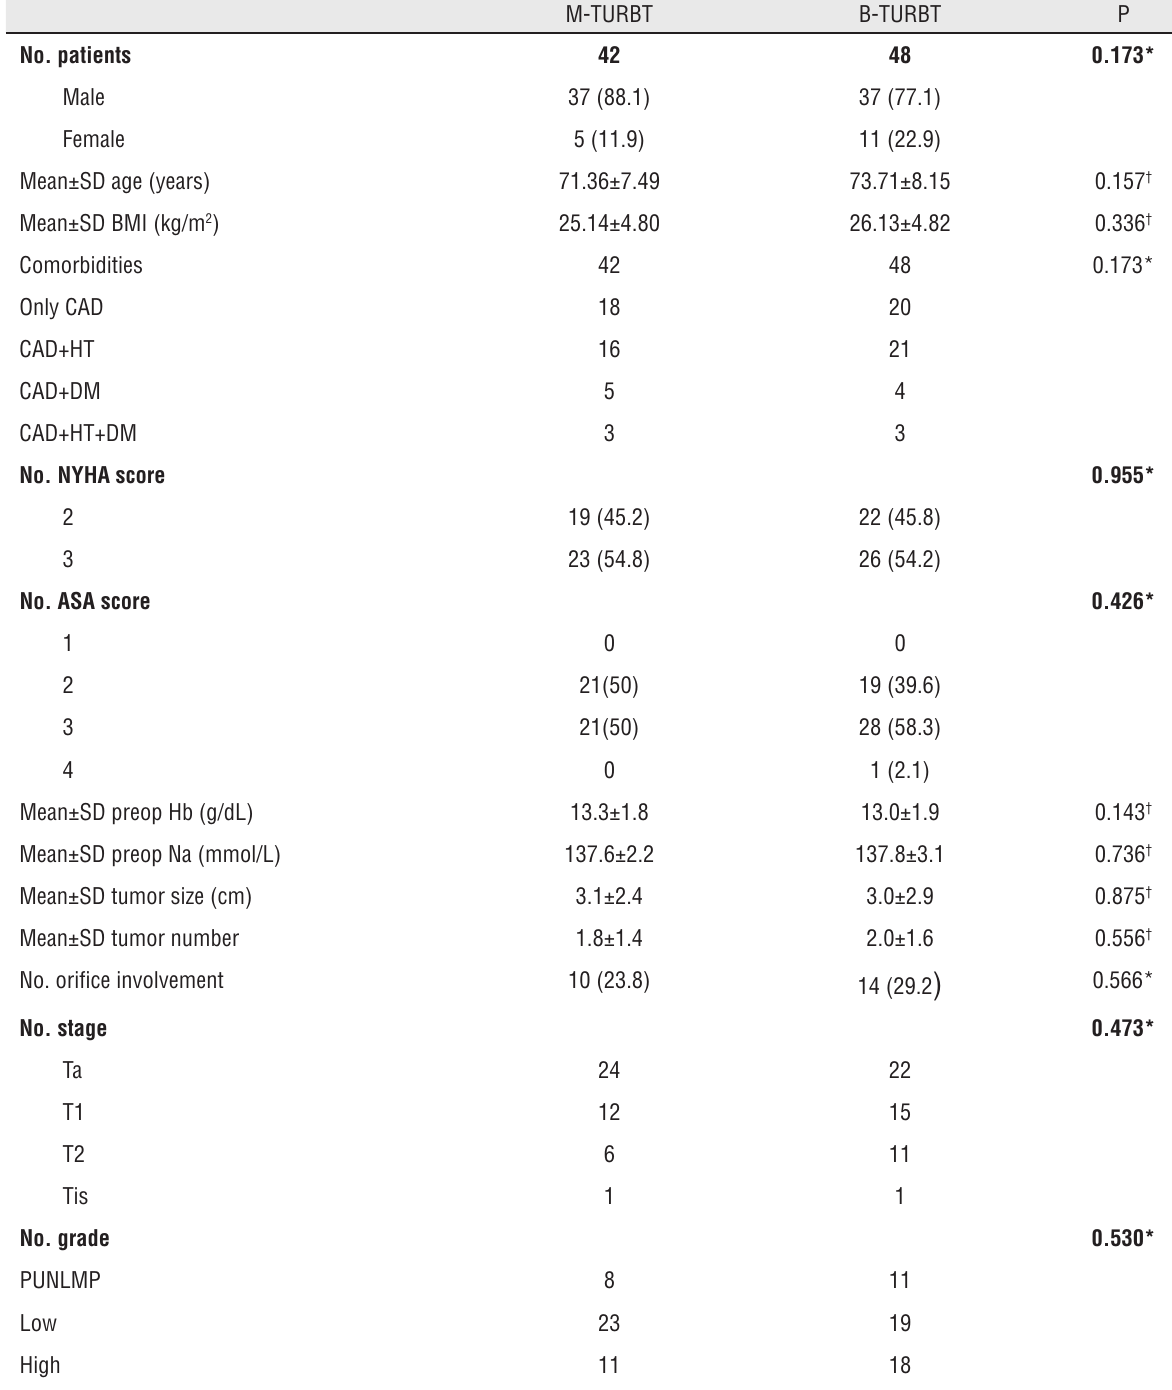
Table 1 - preoperative patient